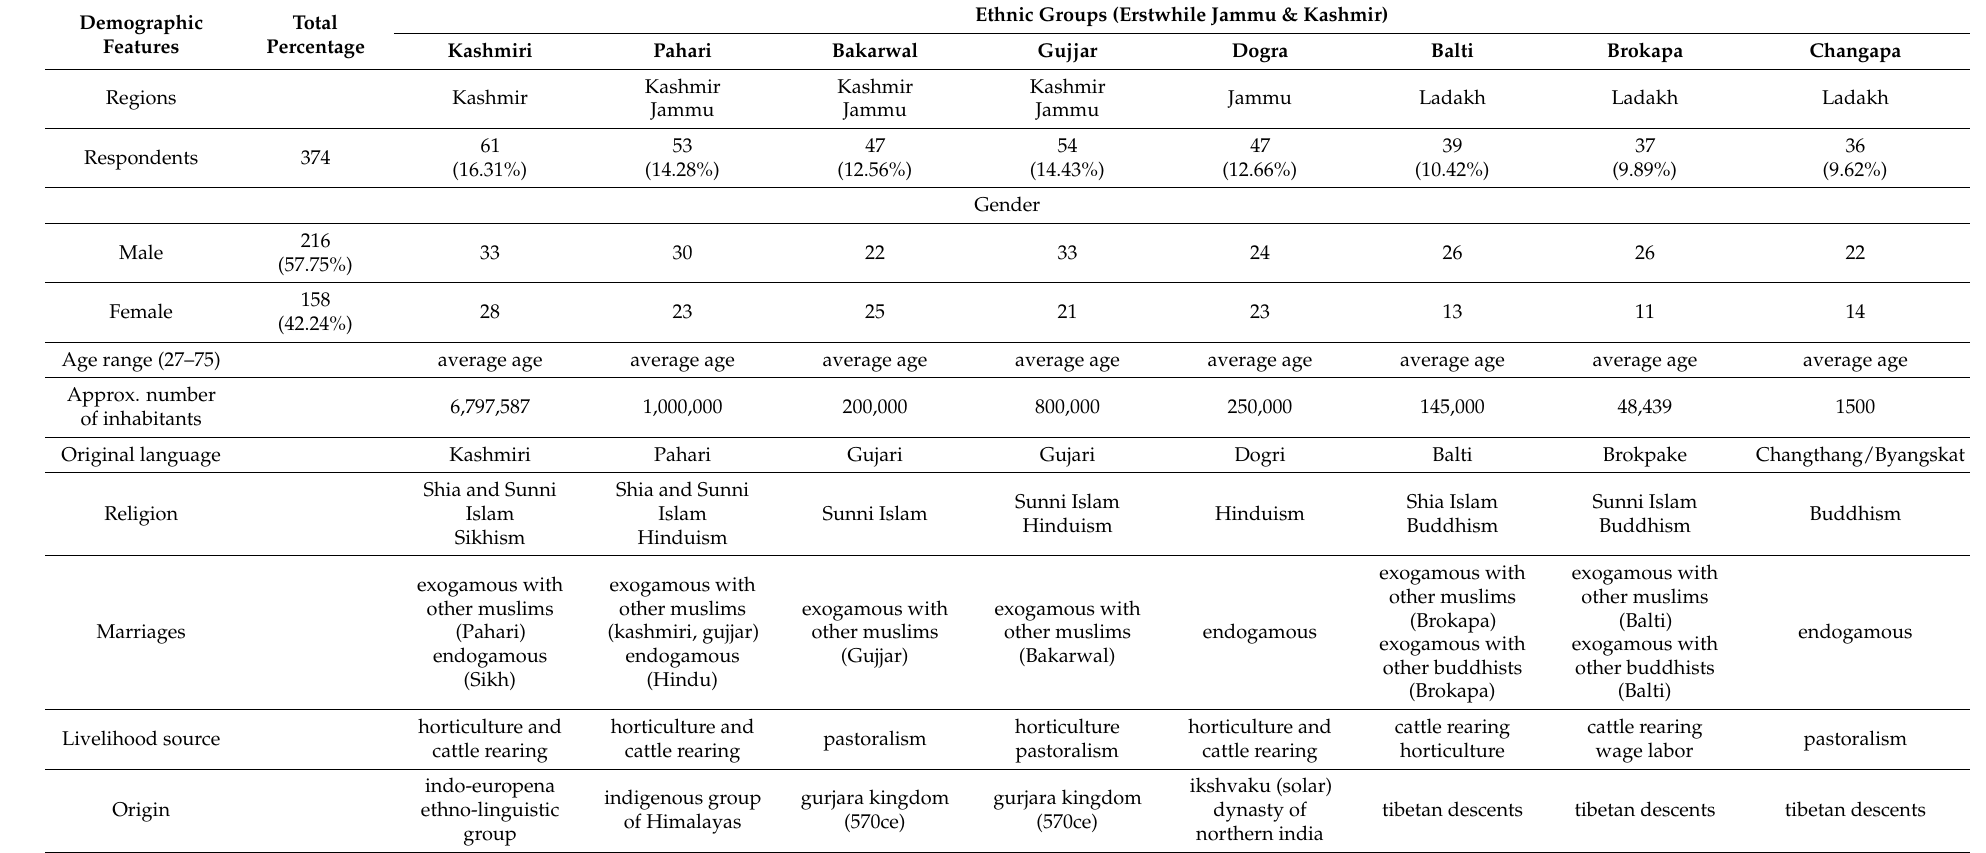
Table 1. Demographic status of the respondents from the study